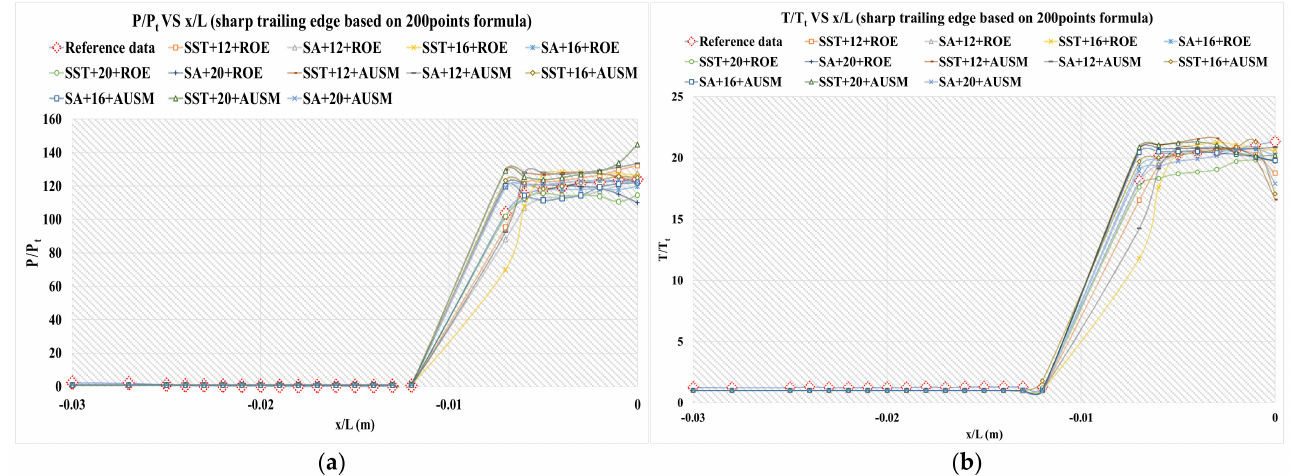
Figure 17. ( a ) Distributions of P/P t of sharp trailing edge based on 200 points formula; ( b ) Distribu- tions of T/T t of sharp trailing edge based on 200 points formula.